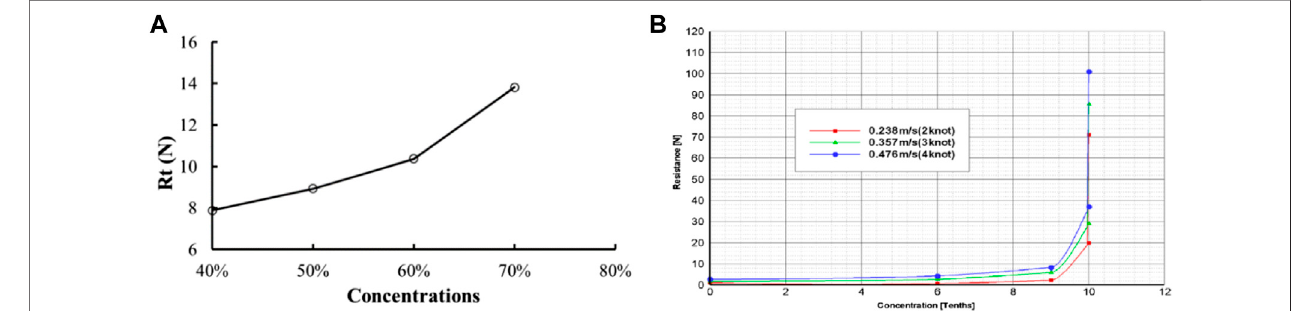
FIGURE 20 | In fl uence of brash ice concentration on ice resistance.